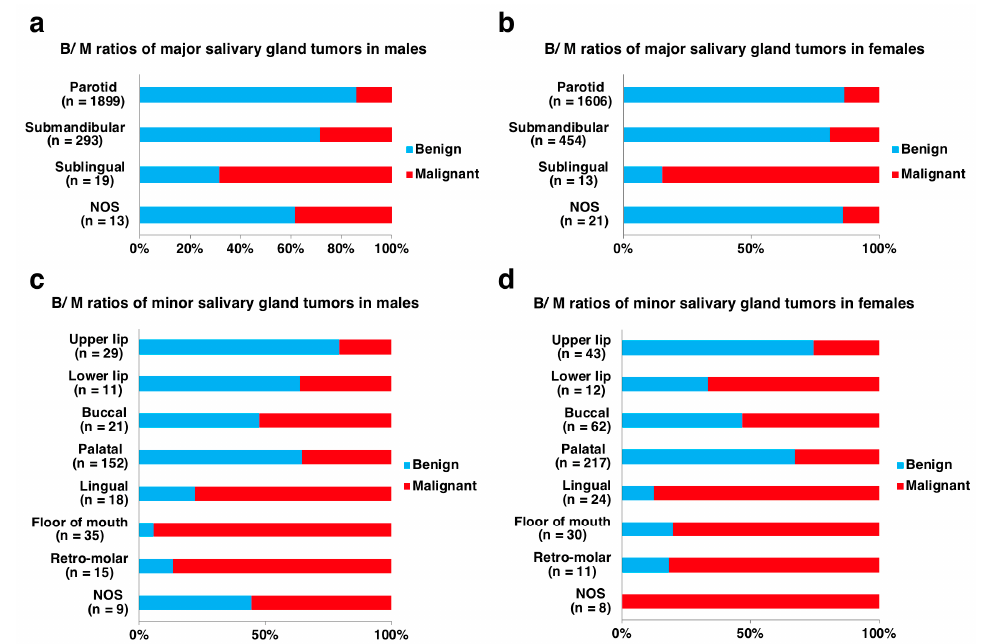
Figure 2. Breakdowns of benign and malignant tumors by sex and detailed location in 4318 major salivary gland tumors ( a , b ) and 697 minor salivary gland tumors ( c , d ). NOS: not otherwise specified.